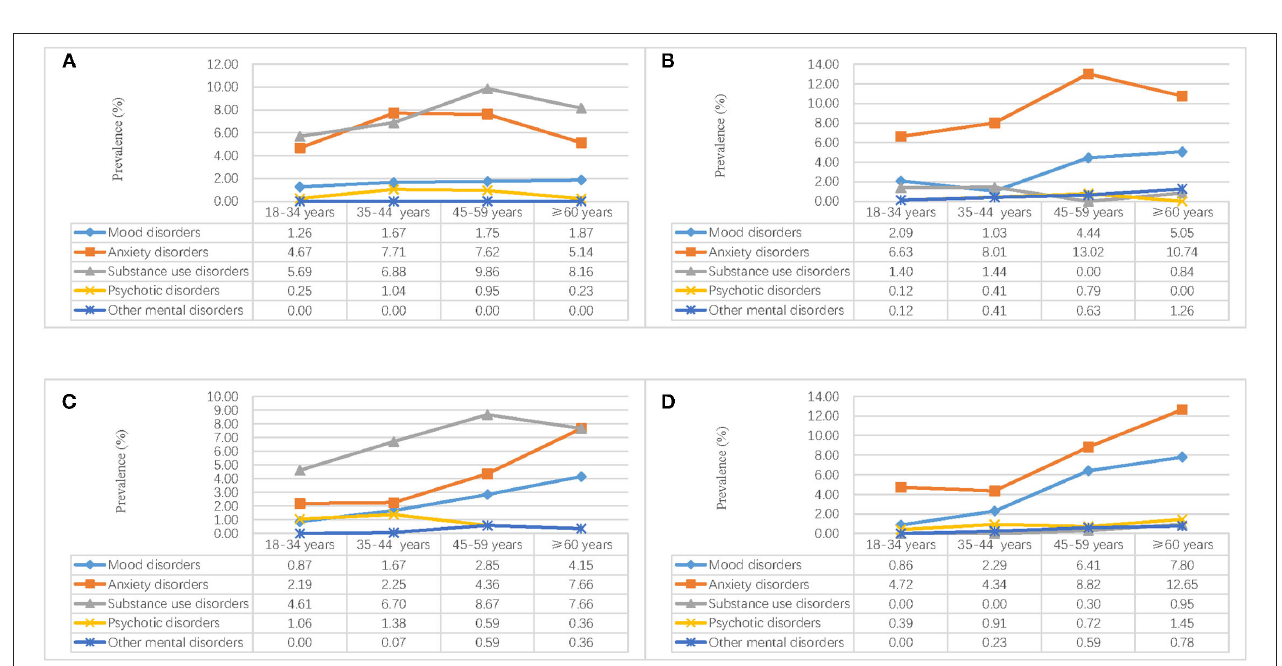
FIGURE 3 | Weighted region-gender-age-specific 1-month prevalence of mental disorders in Hebei province, China. (A) Urban male; (B) Urban female; (C) Rural male; (D) Rural female.